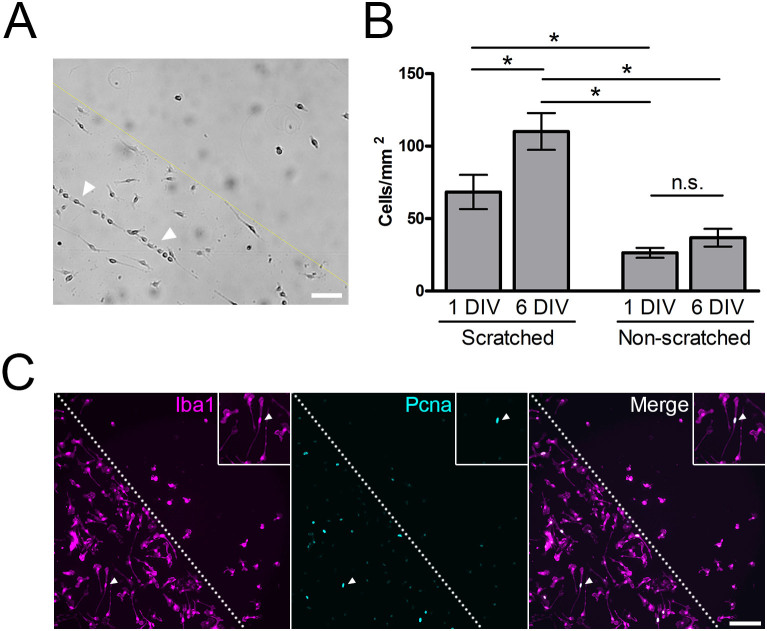
Bipolar/rod-shaped microglia were highly proliferative.(a) Trains of microglia formed along the scratch (left of the dotted line). (b) The density of the microglia significantly increased in the scratched area from 1 DIV to 6 DIV (*P < 0.05 by ANOVA) but not in the non-scratched area (n = 3). (c) Strong signal of the proliferation marker PCNA was localized to the nucleus of the microglia primarily in the scratched area (left of the dotted line). Most of the PCNA+ cells were bipolar/rod-shaped (inset). Scale bar: 100 μm.